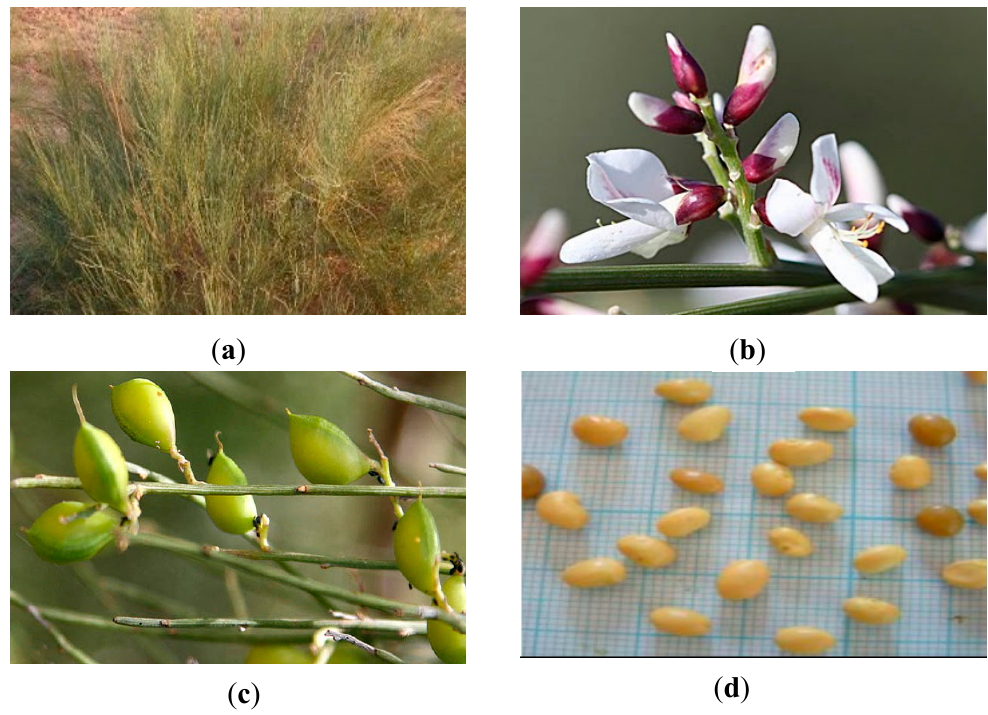
Figure 1. R. raetam (Forssk.) Webb different growth stages: aerial parts of the plant at the vegetative stage ( a ) and details from reproductive stages, namely flowers at the flowering stage ( b ), green fruits at fresh fruiting stage ( c ), and mature fruits at mature fruiting stage ( d ).